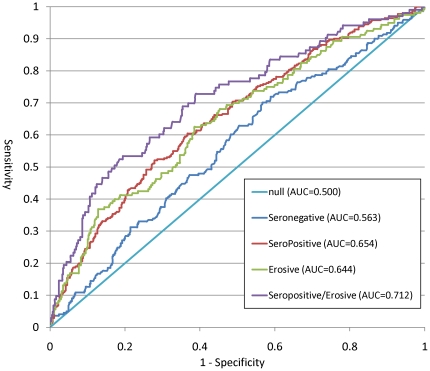
Receiver Operating Characteristic (ROC) curve for 4 phenotypes of RA.